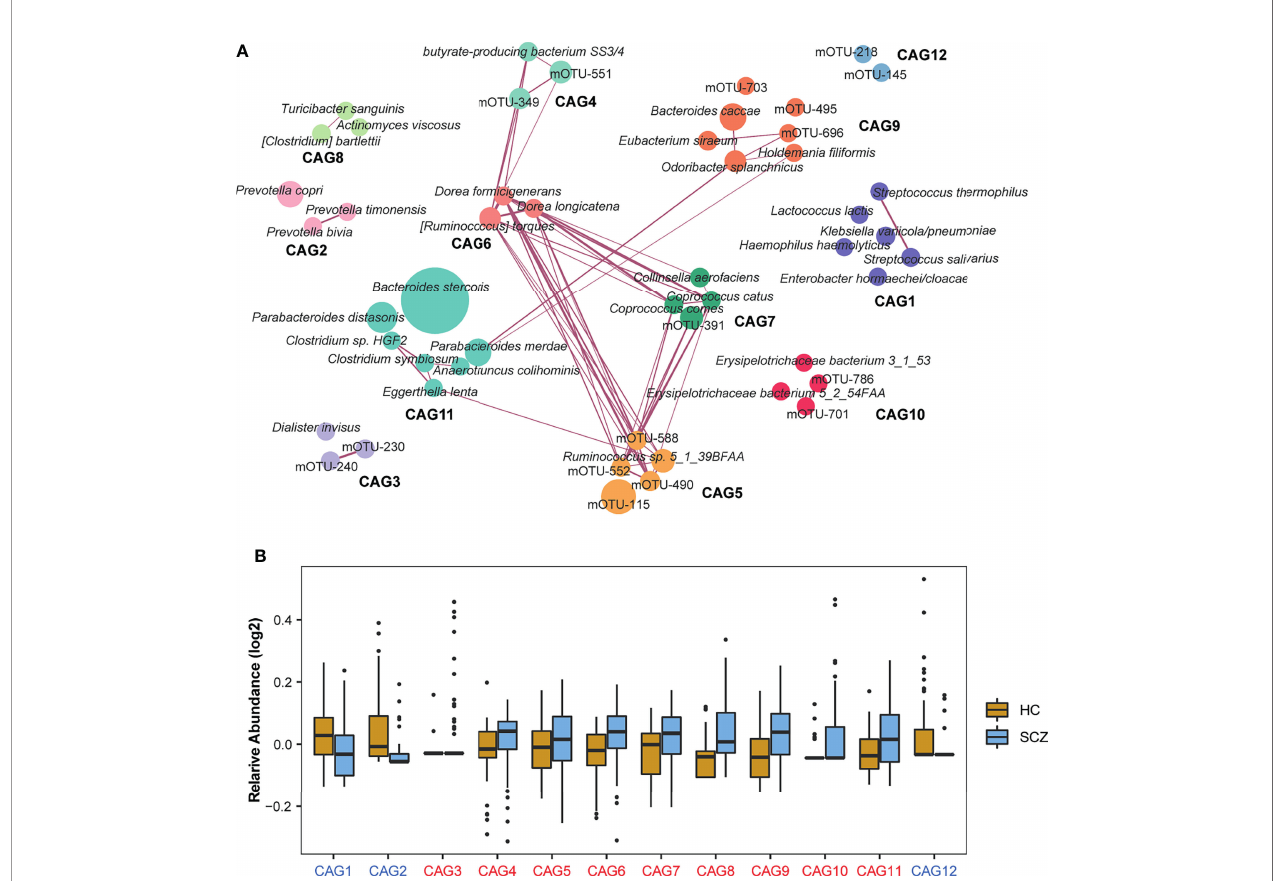
FIGURE 2 | Identi fi cation of the important co-abundance groups (CAGs) that were strikingly different between two groups. (A) Metagenomic operational taxonomic unit (mOTU)-level network diagram showing the enrichments of mOTUs in the different groups based on signi fi cantly changed CAGs. Node size indicated the mean abundance of each mOTU. Lines between nodes represented correlations, with line width indicating correlation magnitude, purple representing positive correlation. Only lines corresponding to correlations with magnitudes greater than 0.4 were drawn. Different colors were used to distinguish CAGs. (B) Relative abundances of 12 CAGs with signi fi cantly differences identi fi ed by the Wilcoxon rank-sum test between the two groups ( P -value < 0.05). The names of the CAGs comprising the schizophrenia-enriched and healthy control-enriched CAGs were highlighted in red and blue,